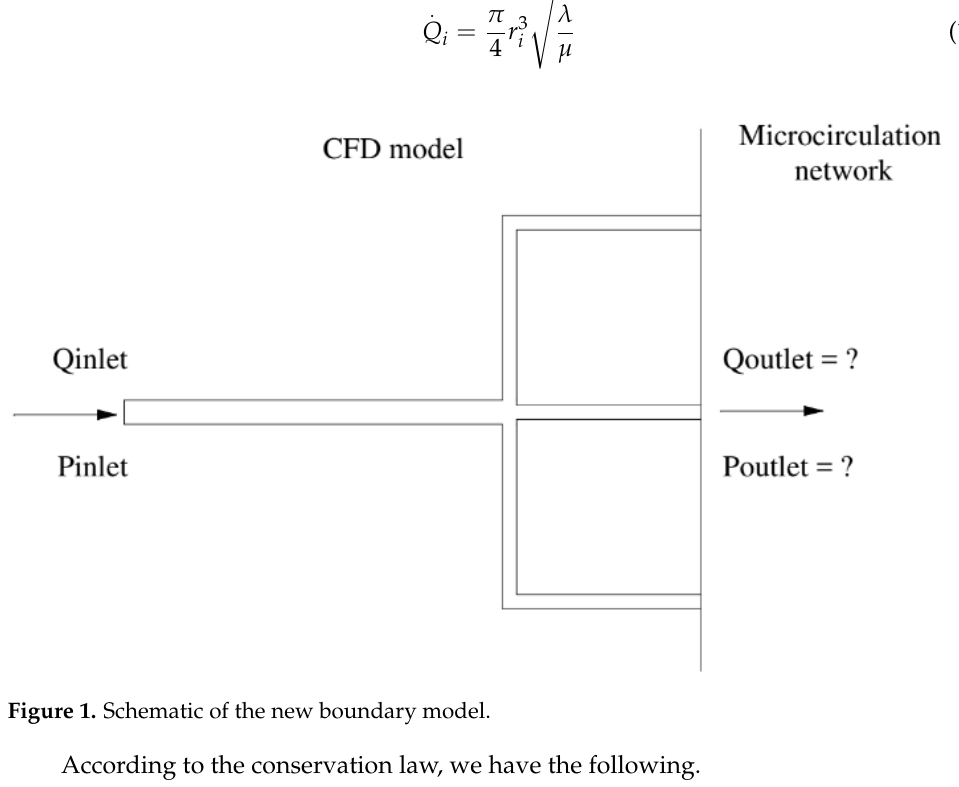
Figure 1. Schematic of the new boundary model.